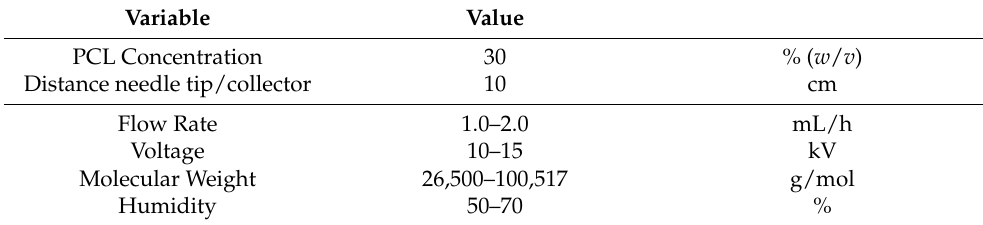
Table 6. Main electrospinning variables